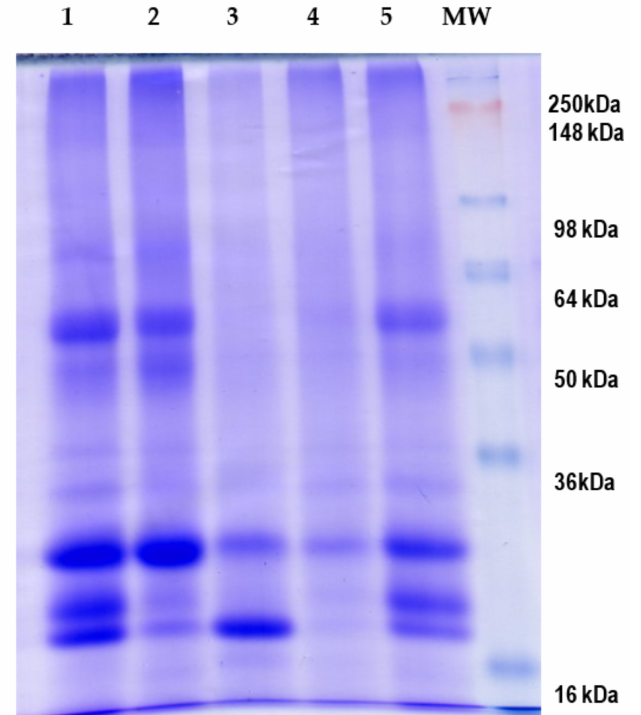
Figure 1. SDS-PAGE analysis of protein fractions obtained from Erythrina edulis (pajuro): (1) albumin; (2) globulin; (3) prolamin; (4) glutelin. (5) Protein concentrate. MW: molecular weight marker SeeBlue™ Plus2 Prestained.